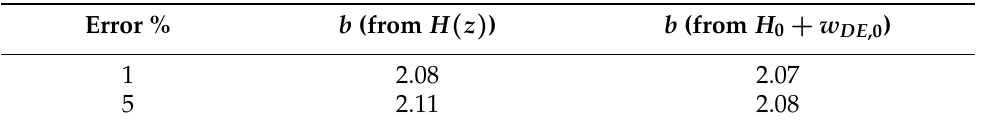
Table 1. The upper limit of b for the corresponding permissible error margin computed from the Hubble parameter estimates and Hubble constant and w DE ,0 combined